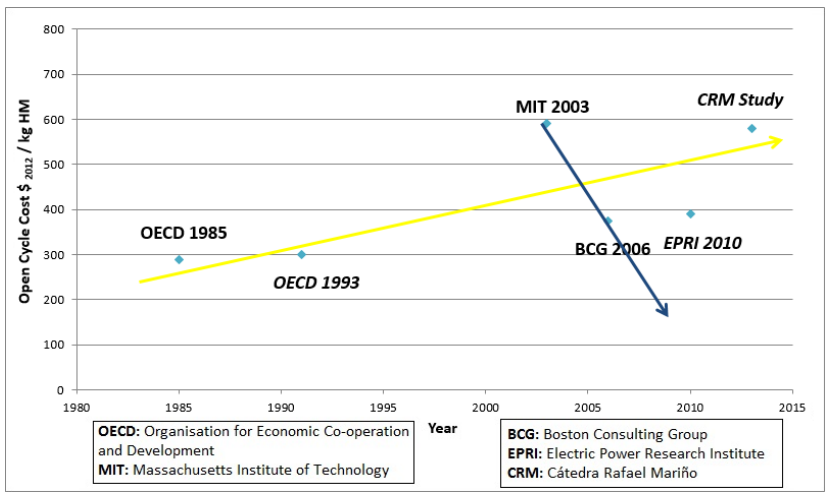
Figure 1. Deep geological repository (DGR) evolution cost.